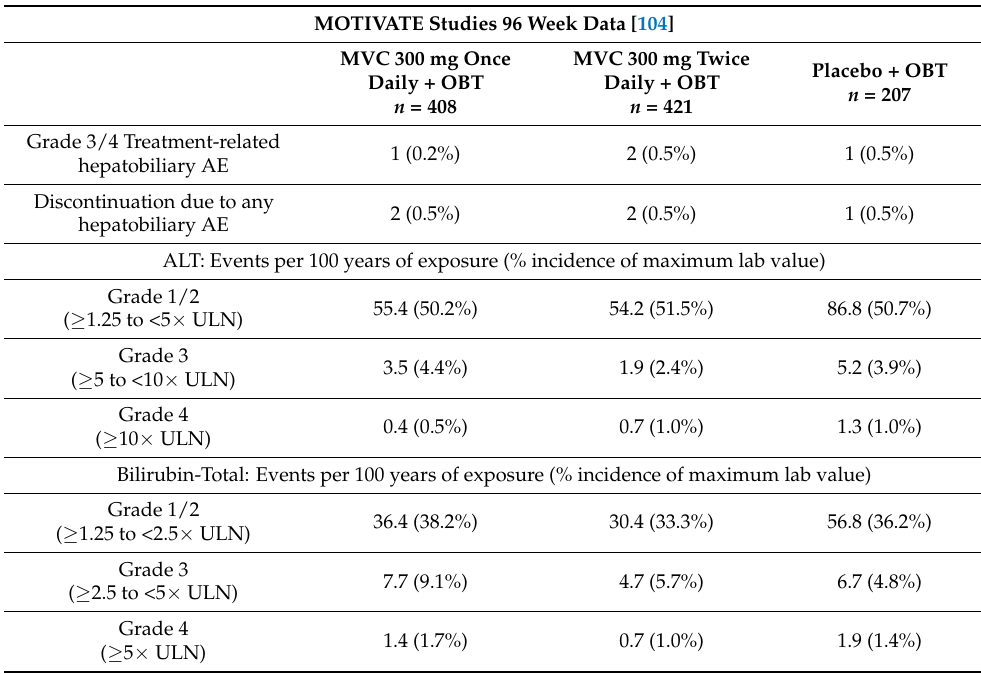
Table 8. ALT/bilirubin, hepatobiliary AEs/discontinuation in MOTIVATE